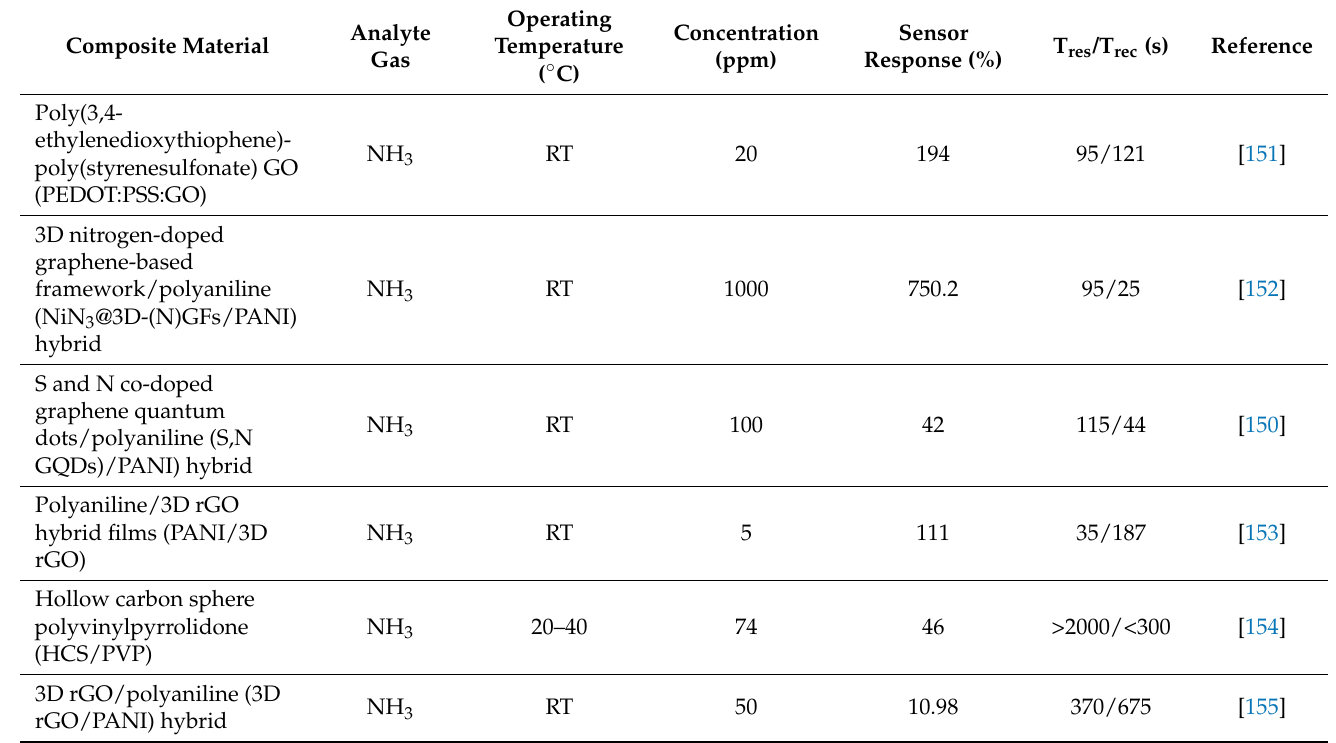
Table 7. Summary of previous studies on graphene-based materials synthesised using the PVD